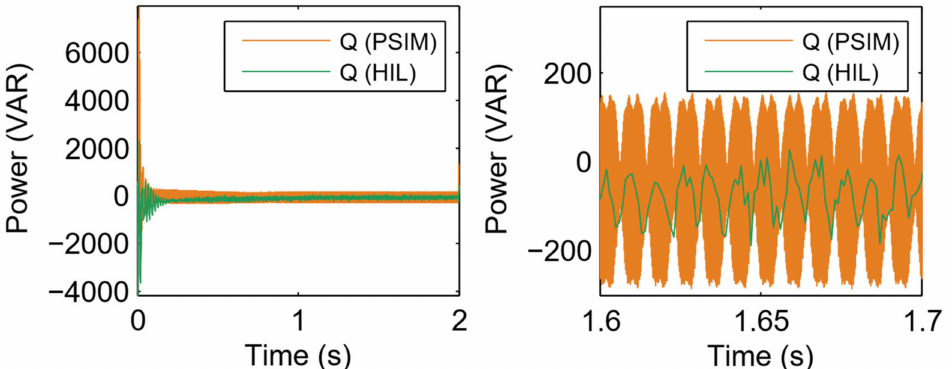
Figure 30. Q response under closed loop and inverter mode